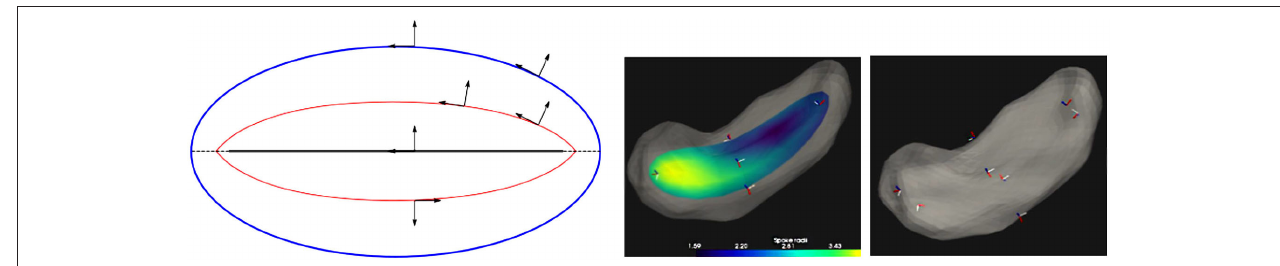
FIGURE 6 | Fitted frames at various places: Left: Frames fitted to skeletal and boundary points on an ellipse in 2D. The solid, thicker, black line is the skeleton, here the spine; the dashed lines are the skeleton extension; the red curve is an onion skin; the blue curve is the ellipse boundary; arrows are local frames. Middle and Right: The hippocampus (gray); middle: with its s-rep’s skeleton (colored, with the color at a place on the skeleton showing the width of the object at that place) and fitted frames (blue element is normal) at the object center point and four points along and across the skeleton; right: the hippocampus boundary with fitted frames at points at ends of spokes at the skeletal points in the middle frame.